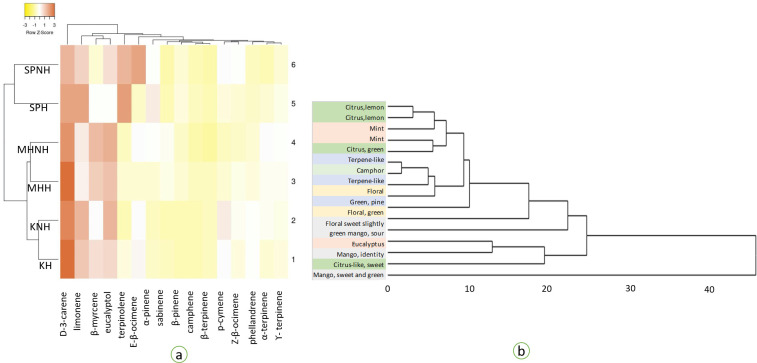
Intensity heat-mapping of the volatile compounds from solid-phase micro extraction of Thai mango purée (a) and the dendrogram of their aroma characteristics as described in Boonbumrung et al. [59]; Alvarez et al. [46] and Maldonado-Celis et al. [6] (b); ‘sam-pee’(SP) ‘maha-chanok’ (MH) and ‘keaw’ (K), following by H indicates sample subjected to thermal processing at 85°C for 15 minutes and NH indicates non-heat treatment.